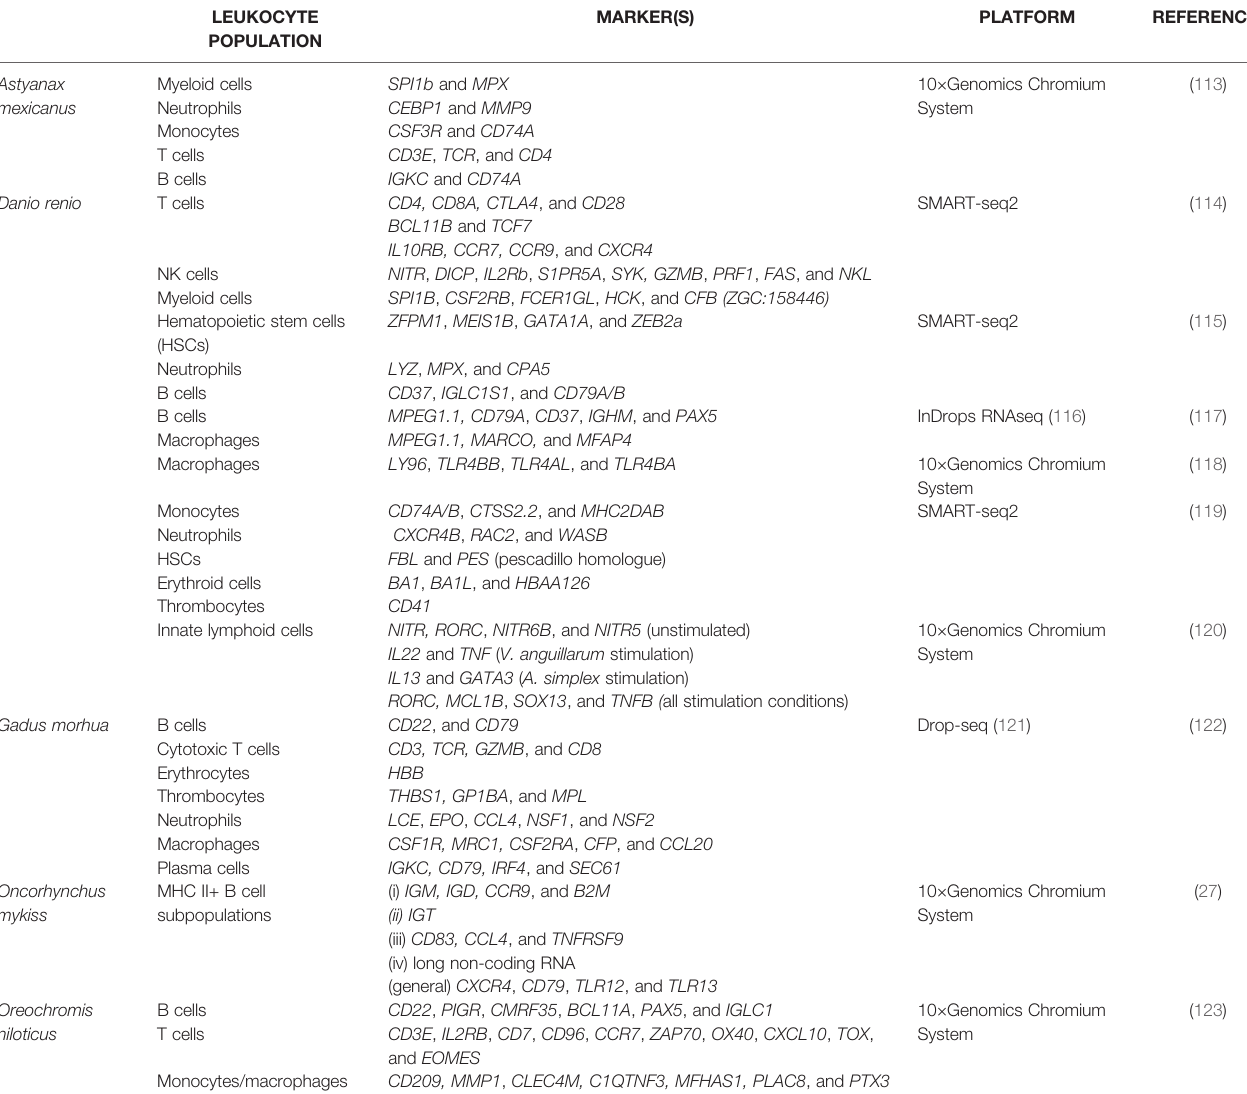
TABLE 2 | A summary of select literature on scRNA-seq of teleost fi sh immune cells. LEUKOCYTE